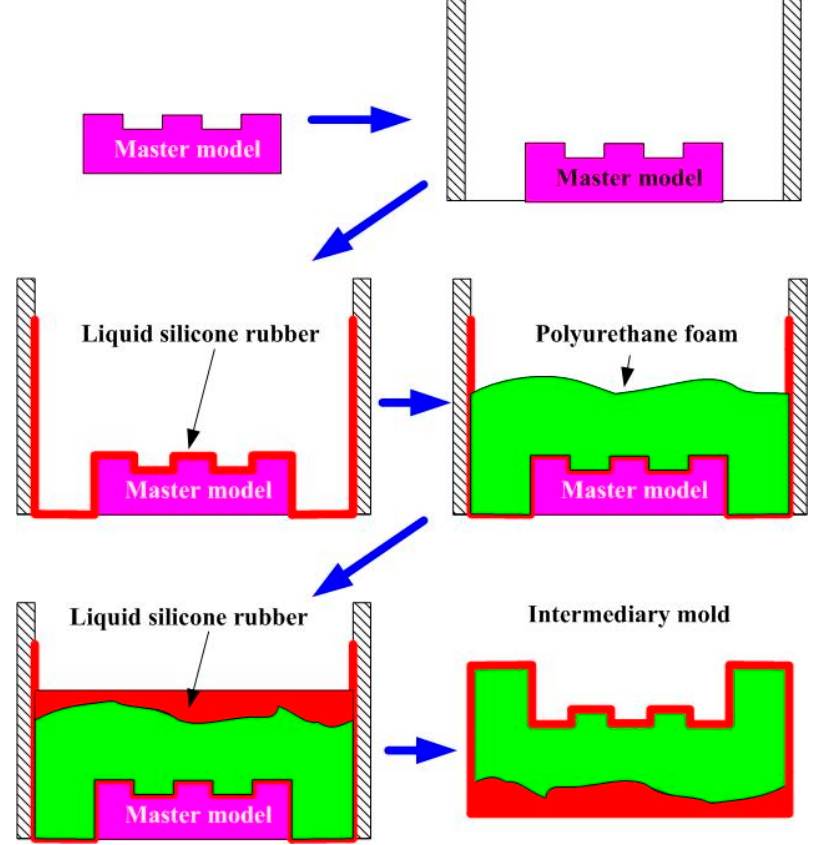
Figure 24. An innovative method for fabricating an intermediary mold for large rapid tooling (RT) with. (RT)